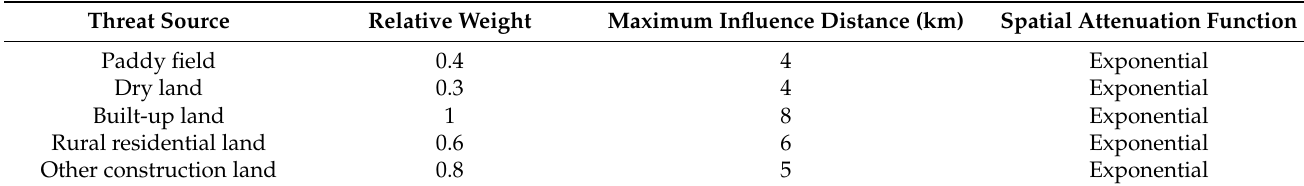
Table A3. Threats and their weight and the maximum distance of